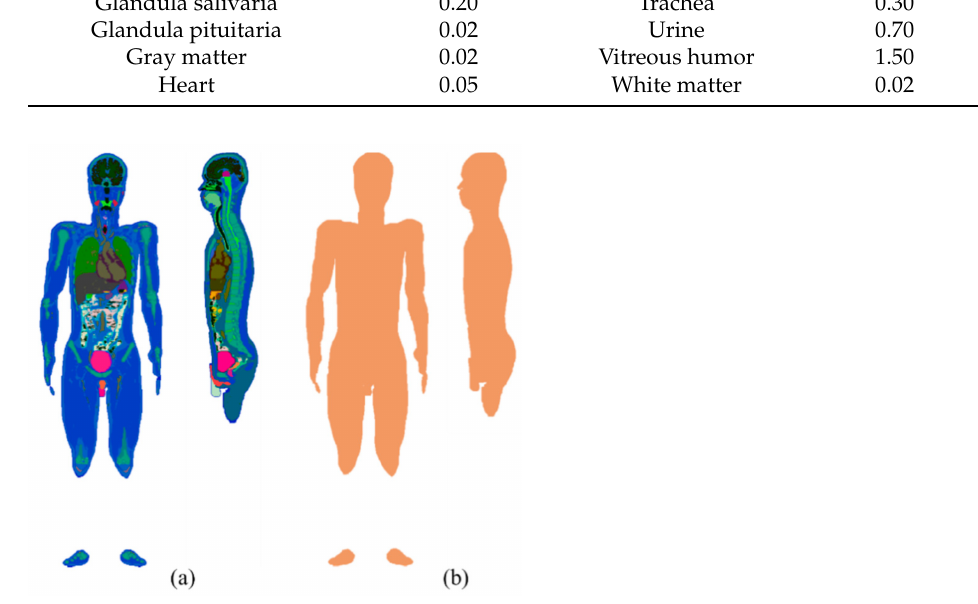
Figure 2. Coronal (left) and sagittal (right) cross-sectional slices of ( a ) TARO and ( b ) its homogenized